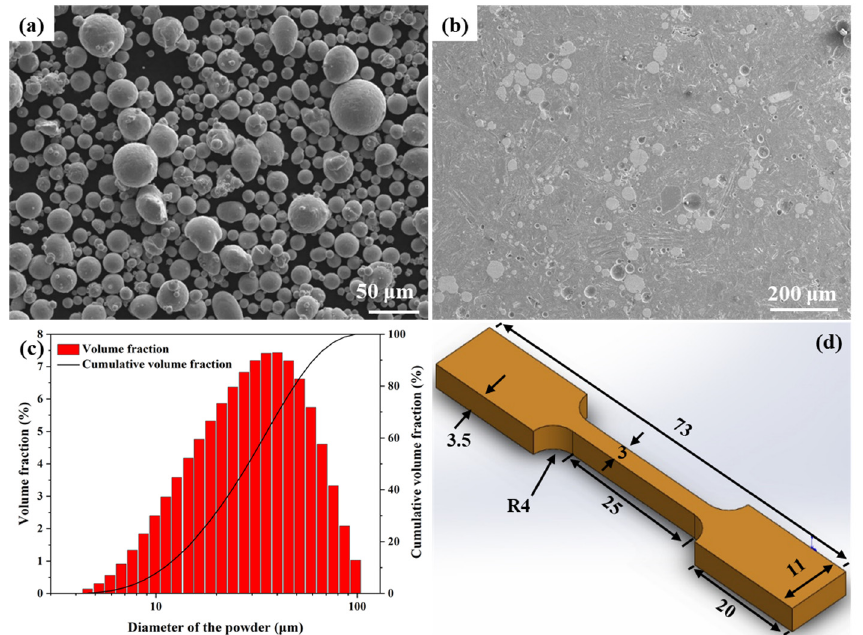
Figure 1. The Cu–Cr–Nb–Ti alloy powders and tensile sample: ( a ) powder morphology, ( b ) powder internal structure, ( c ) particle size distribution, and ( d ) tensile sample diagram.